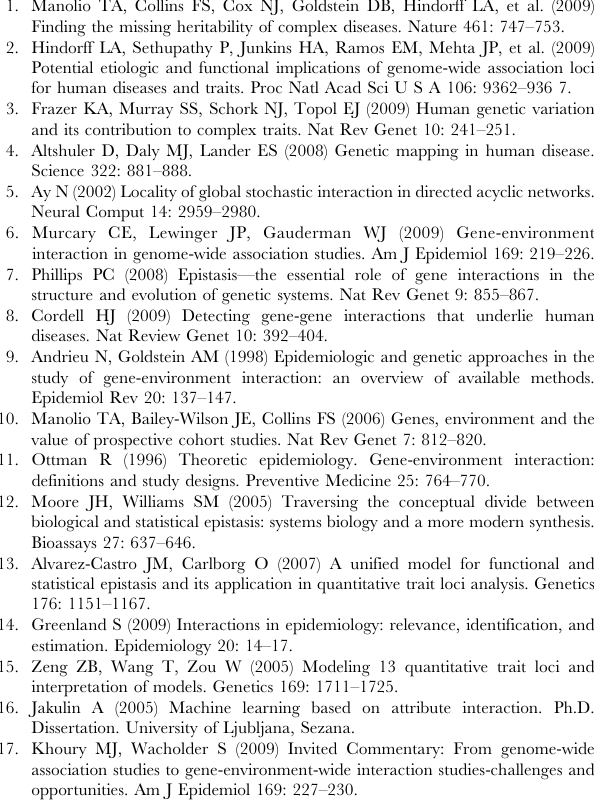
Table S4 P-value for testing interaction calculated by T IH , PLINK and logistic regression using genotype